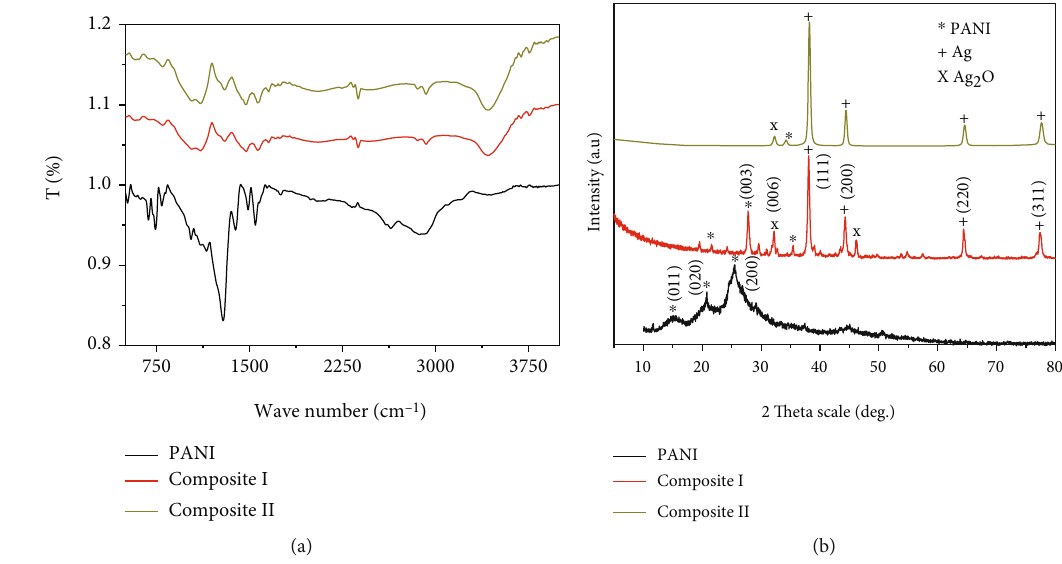
Figure 2: (a) FTIR and (b) XRD analyses of PANI and PANI/Ag Table 2: The FT-IR spectra of PANI and PANI/Ag Band position (cm − 1 ) PANI